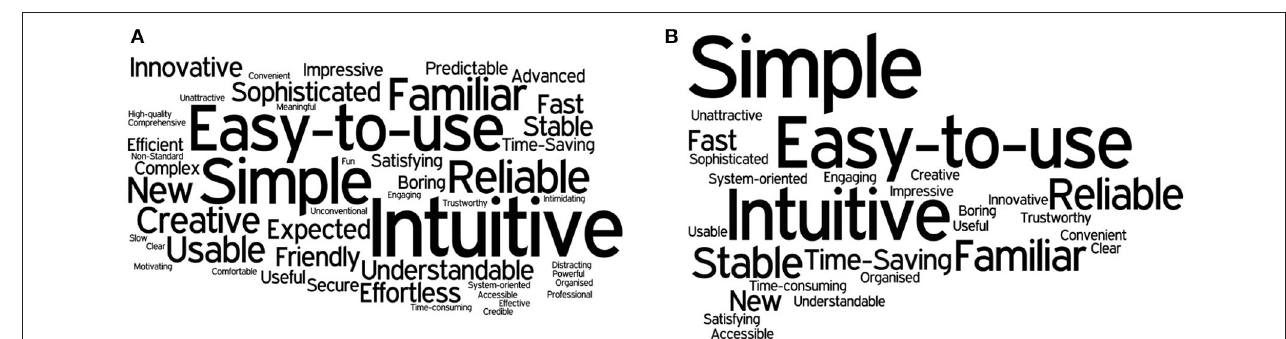
FIGURE 11 | Word clouds from the results of the desirability survey. (A) First selection word cloud. (B) Final 5 words selection cloud.